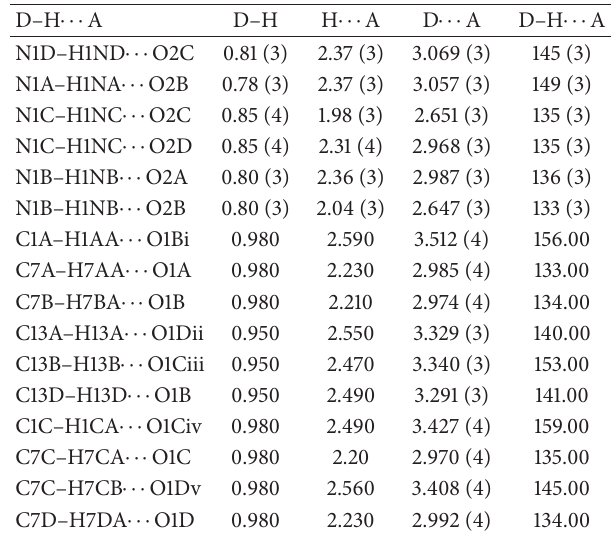
Table 3: Hydrogen-bond geometry for compound 2 (˚A, ∘ ).